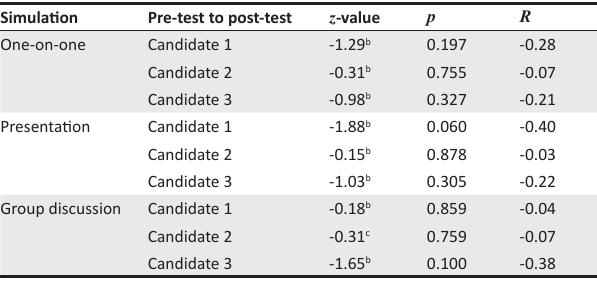
Experimental group: Pre-test Experimental group: Post-test